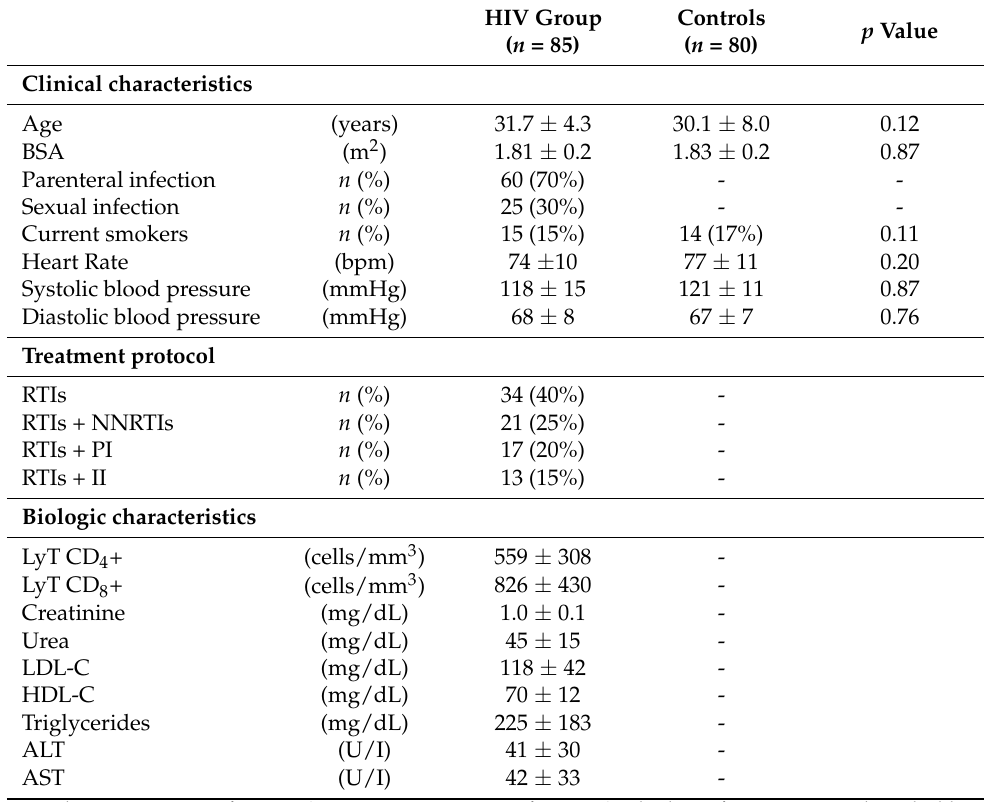
Table 1. Anthropometric and clinical